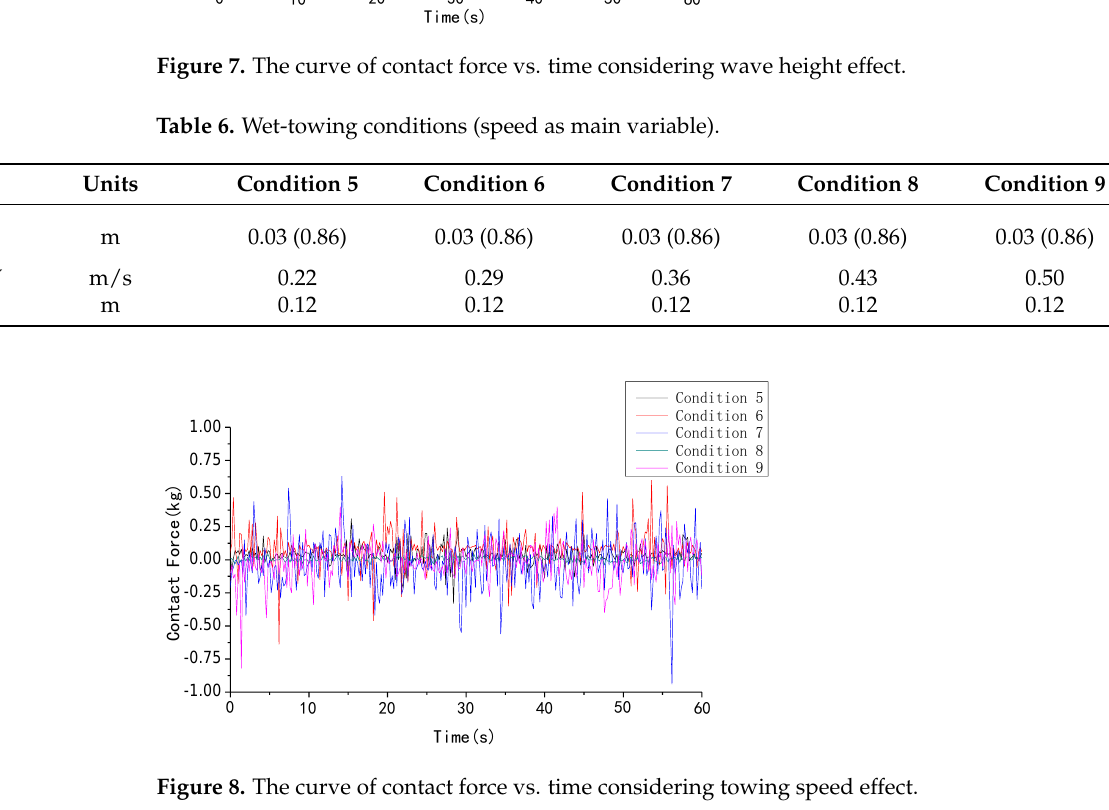
Table 7. Wet-towing conditions (draft depth as main